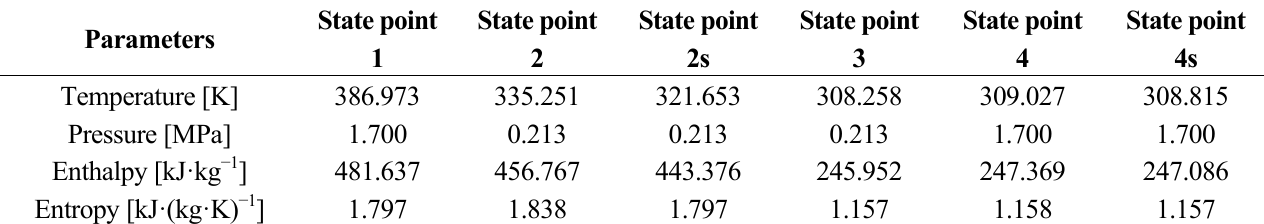
Table 4. Thermodynamic parameters of each state point of the ORC